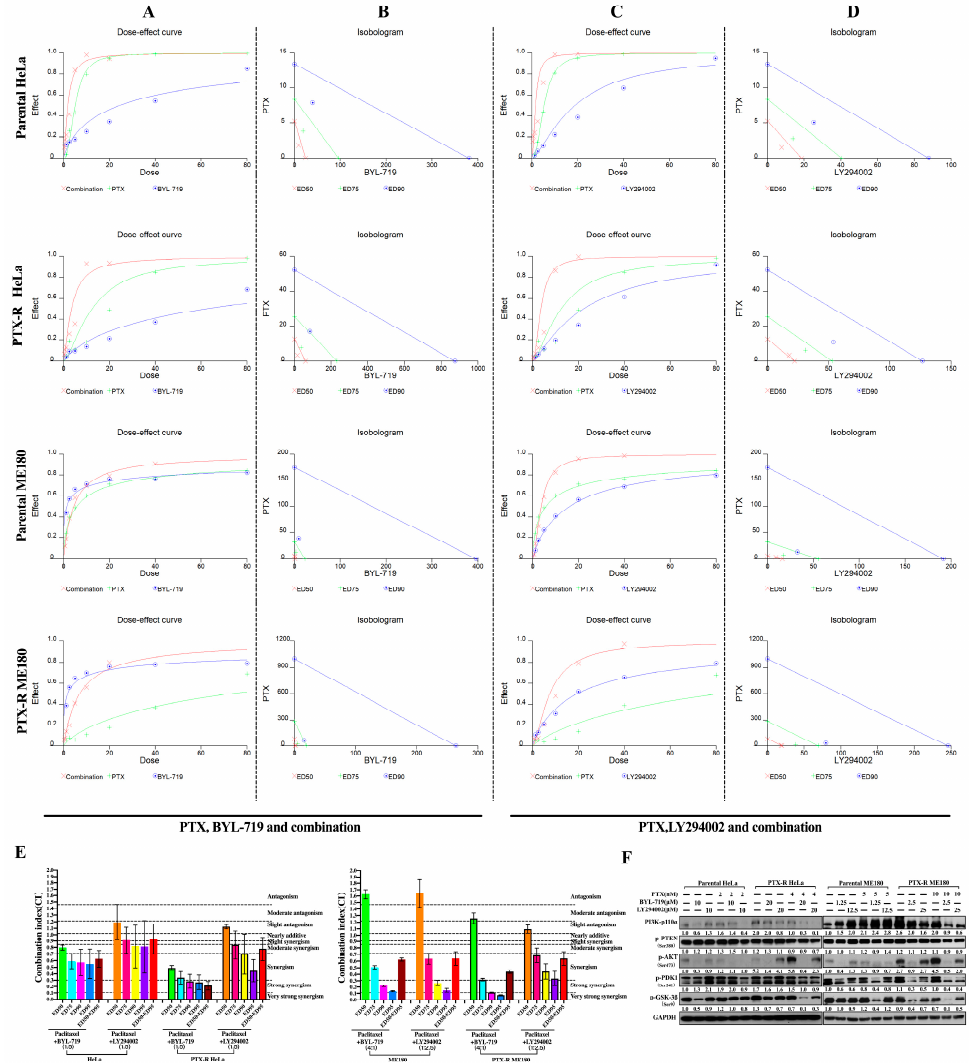
Figure 3. Synergistic interaction of BYL-719 or LY294002 in combination with paclitaxel in the treatment of parental and paclitaxel-resistant HeLa and ME180 cervical cells and its e ff ects on the phosphatidylinositol 3-kinase (PIK3) / p-Akt / p-phosphatase and tensin homolog (PTEN) signaling pathway. Both parental and paclitaxel-resistant (PTX-R) HeLa cells were exposed to either BYL-719 (BYL, 1.56–100 µ M) or LY294002 (LY, 1.56–100 µ M) alone or in combination with a fixed molar ratio of PTX (PTX:BYL = 1:5, PTX:LY = 1:5 ), while parental ME180 and PTX-R ME180 cells were exposed to either BYL (0.078–5 µ M) or LY294002 (1.56–100 µ M) alone or in combination with PTX at a fixed molar ratio (PTX:BYL = 4:1, PTX:LY = 1:2.5). The dose–e ff ect curves for PTX alone (green), PTX alone (blue) and combination (red) are shown in ( A ) and ( C ) panels for parental and PTX-R HeLa / ME180 cells, respectively. A multiple e ff ect–level isobologram analysis is shown in ( B ) and ( D ) panels for a 90% e ff ective dose (ED90) ( (cid:12) ), ED75 ( + ) and ED50 ( х ) in both parental and PTX-R HeLa / ME180 cells. Experimental data points, represented by dots located below, on, or above the line, indicate synergism, additivity, and antagonism, respectively. ( E ) The combination index (CI) values for BYL or LY in combination with paclitaxel at ED50, ED75, ED90, ED95 and ED50 -95 (average of CI values at ED50, ED75, ED90, and ED95) for parental and paclitaxel-resistant HeLa and ME180 cell